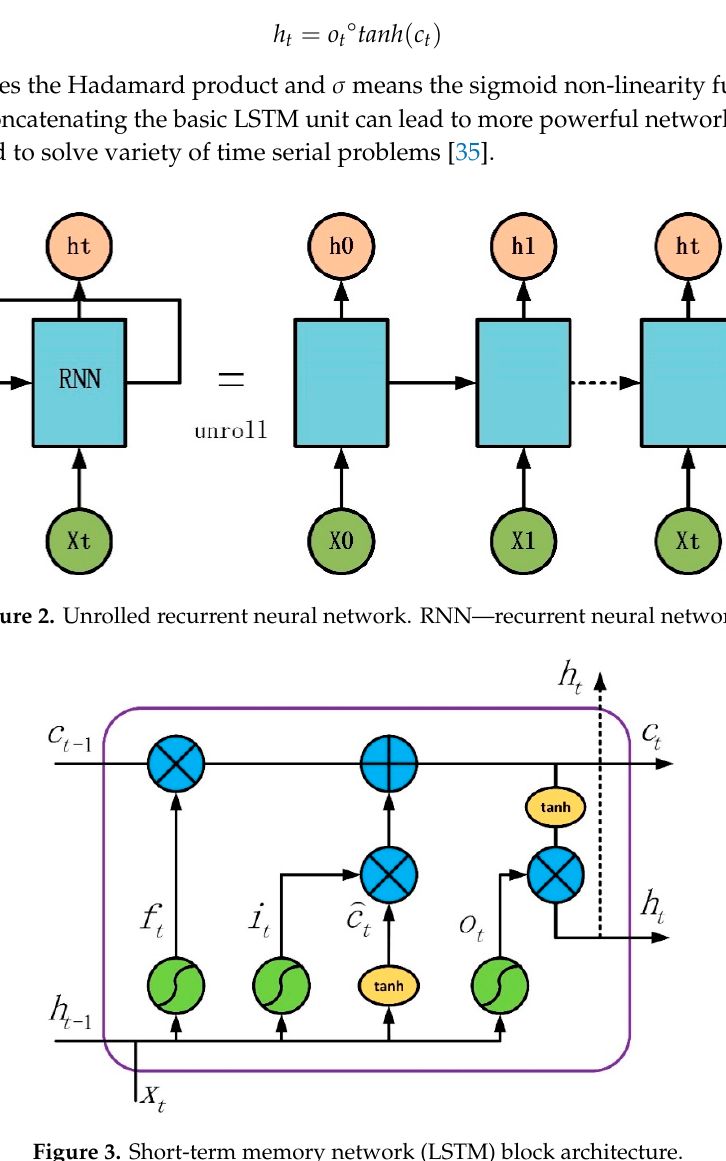
Figure 3. Short-term memory network (LSTM) block architecture.